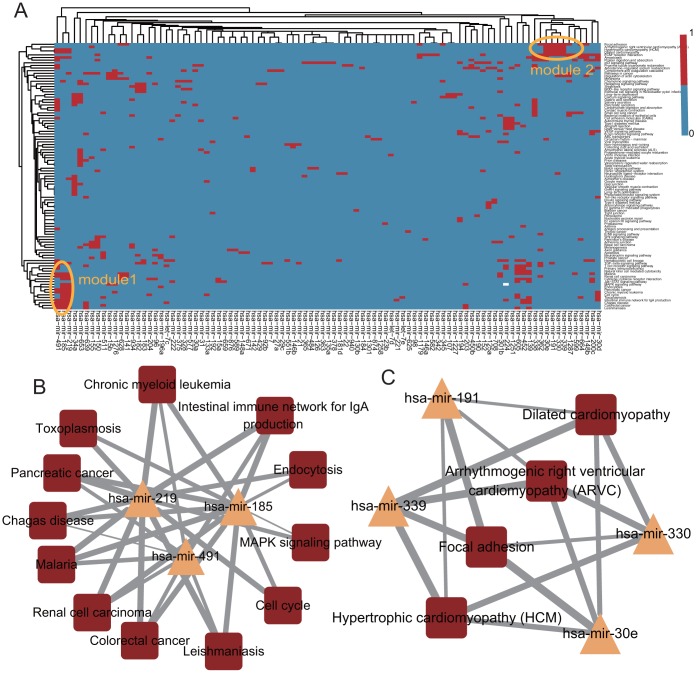
The analyses of synergistically dysregulated pathways by miRNAs.A. A heatmap of the synergistically dysregulated pathways by miRNAs; bi-directional hierarchical clustering was performed using the R package. The two yellow ellipses represent module 1 and module 2, respectively. B. The sub-network of module 1.C. The sub network of module 2.